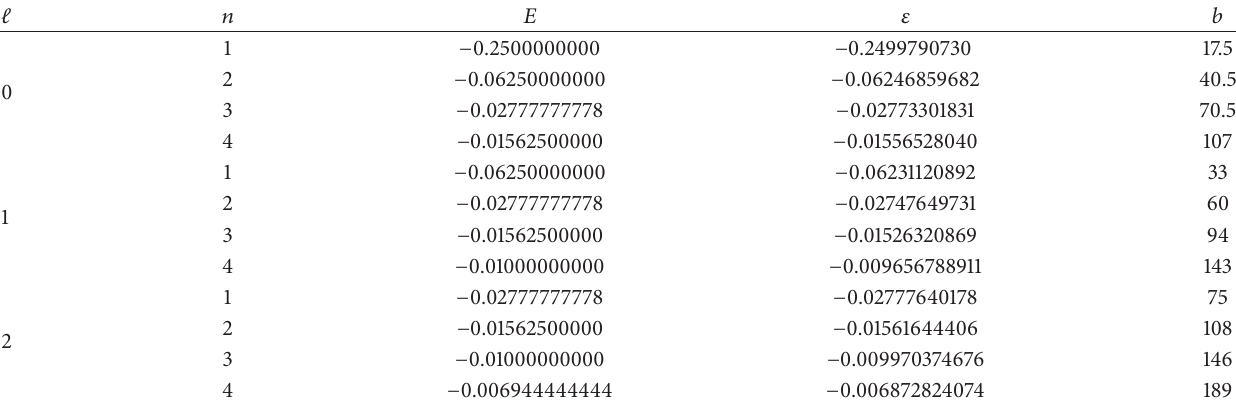
Table 5: Approximation of the energy levels of the hydrogen atom in dimension 𝑑 = 3 , for quantum numbers ℓ = 0,1, 2 . Note that the variational parameter that minimizes the upper bound tends to be very large for all the states. The error is of the order of 10 −4 in the “best” cases.